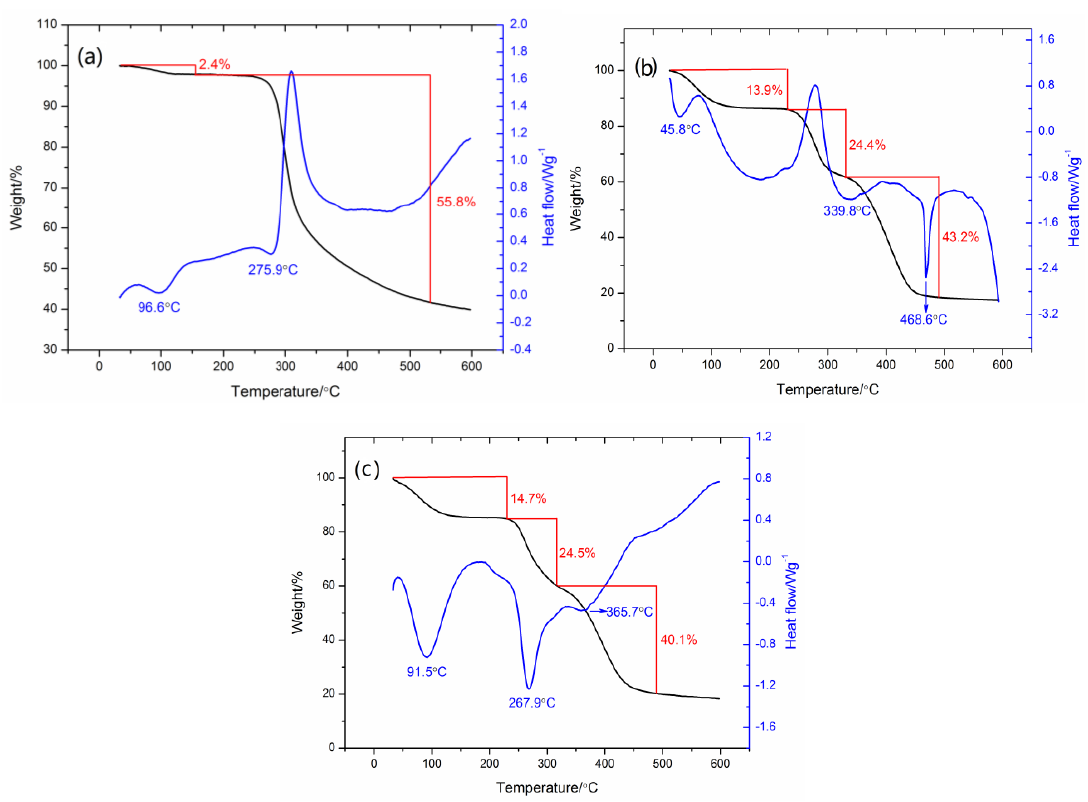
Figure 4. Thermogravimetric curves of ( a ) CTS, ( b ) P(AM-DMC), and ( c ) CTS- g